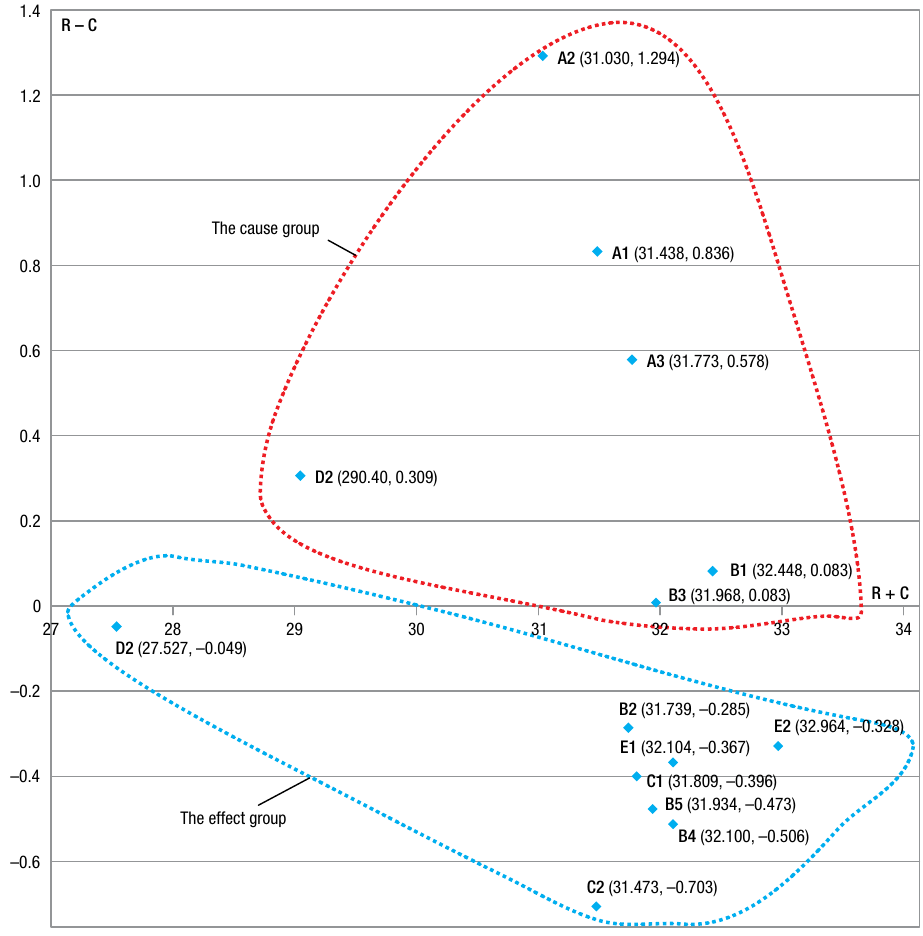
Fig. 1. The causal